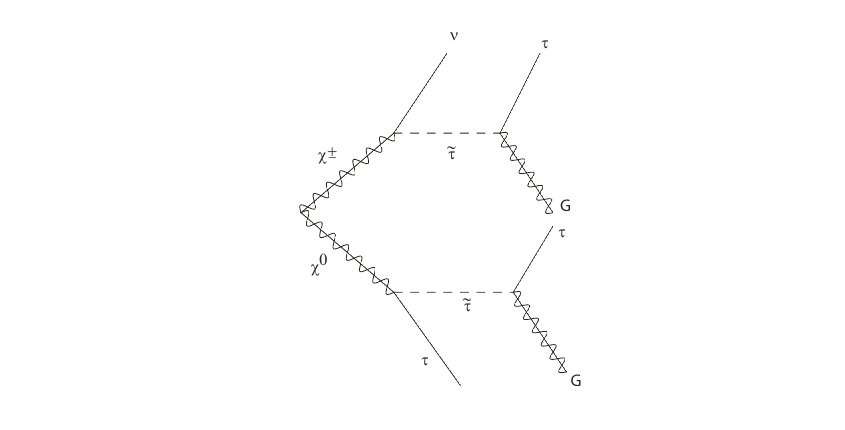
Figure 2 . Typical heavy and light (cid:13)avor squark decay chains in an Antisplit scenario with stau NLSP.